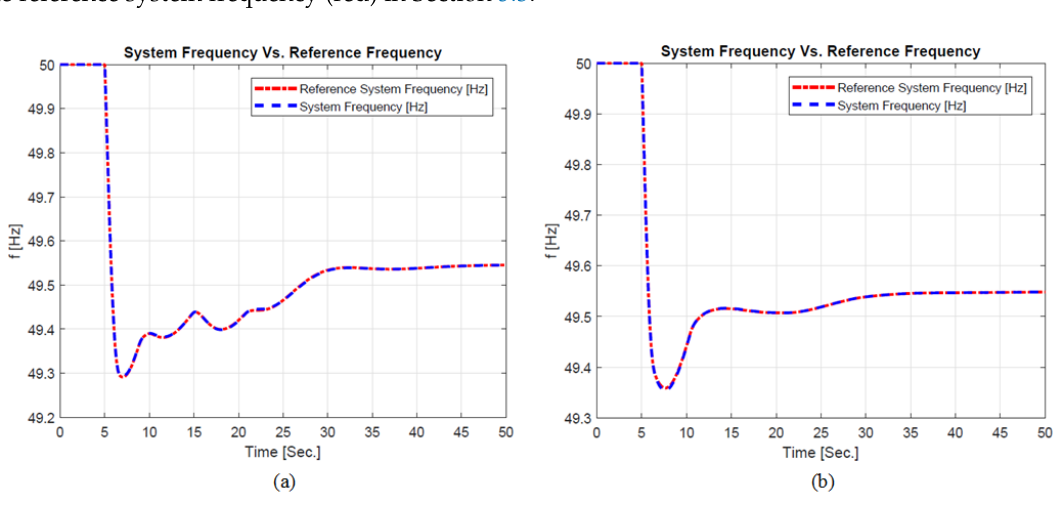
Figure 10. System Frequency Compared to the Reference Frequency at ( a ) Partial and ( b ) Full